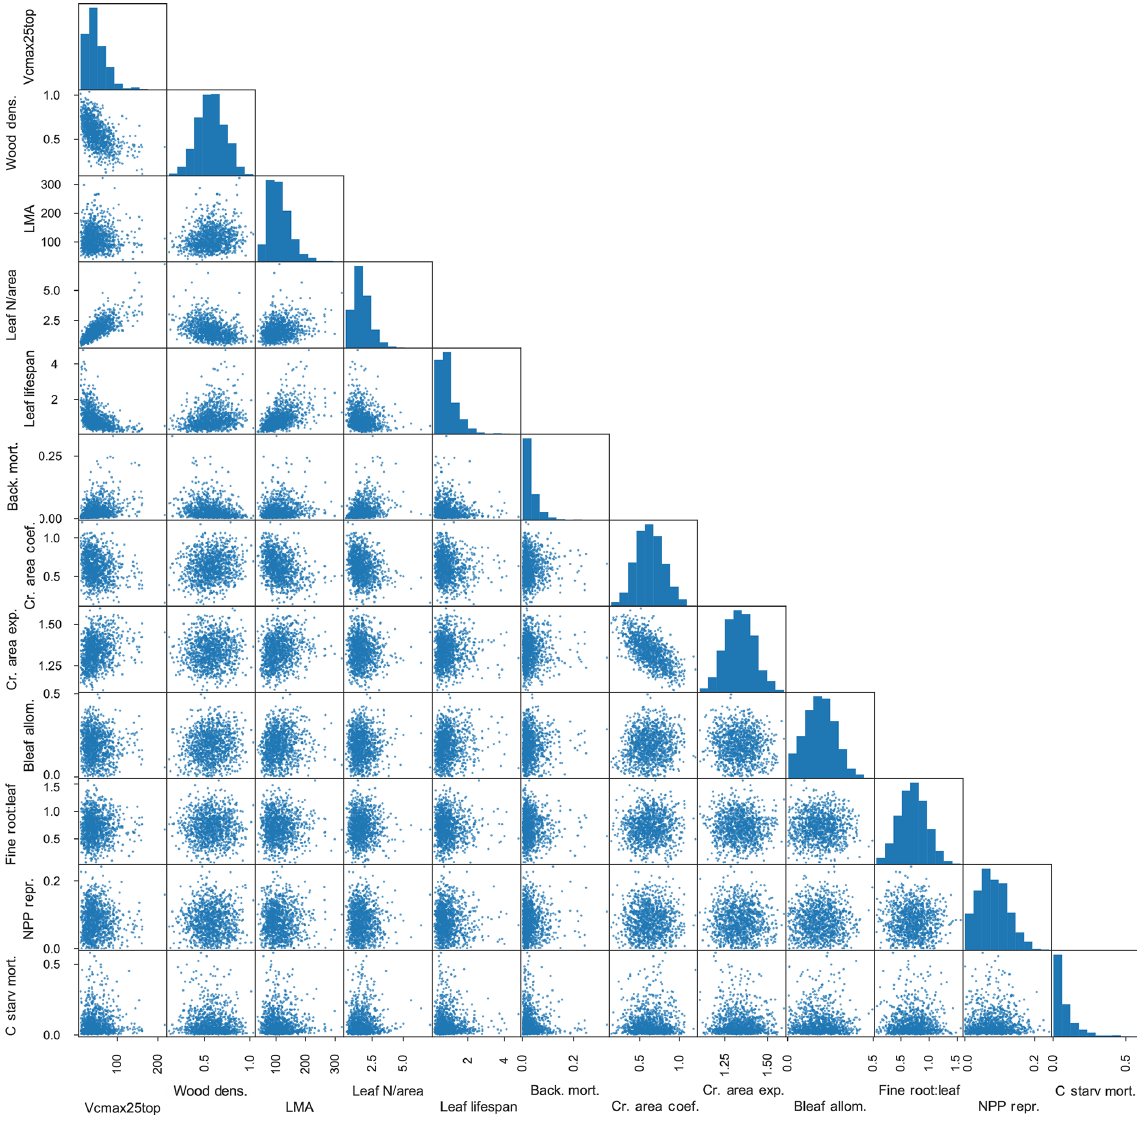
Figure 4. Resampled trait matrix, including eight observed and four unobserved traits, as used to define PFTs in FATES simulations. Eight observed traits are as in Fig. 3 (with background mortality set to be the observed plant mortality). Four additional unobserved traits are as follows: allometric coefficient of relationship of leaf biomass to stem diameter (kgcm − 1 ), allometric ratio of fine-root biomass to leaf biomass (unitless), fractional NPP allocated to reproduction (unitless), and maximum rate of carbon starvation mortality (yr − 1 ). Bleaf is leaf